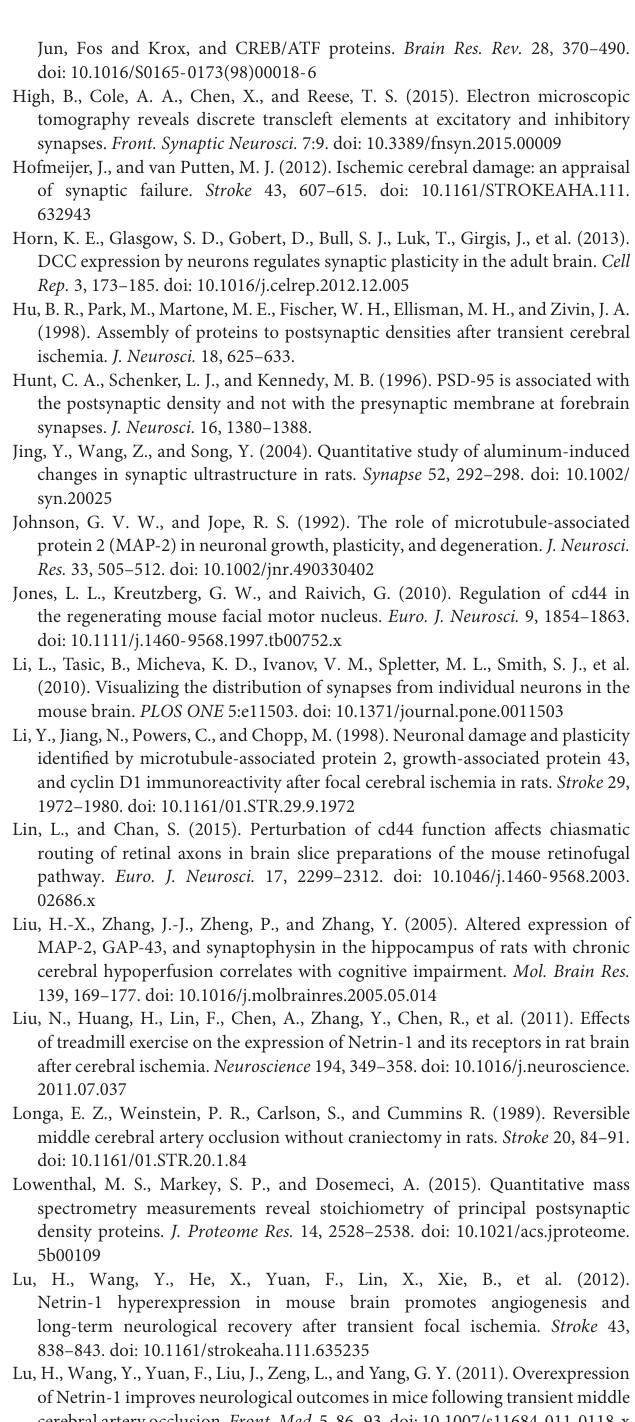
FIGURE S3 | Western-blot analysis of the supplementary groups. (A) The representative images of western-blot analysis for NF-200, GAP-43 and MAP-2. Rats in each group were sacrificed at Day 14 after the MCAO. (B) Western-blot analysis of NF-200 ( n = 3). (C) Western-blot analysis of GAP-43 ( n = 3), ∗ p < 0.01, as compared with the AAV-empty group, ∗ p < 0.05, as compared with the AAV-empty + DMSO group. (D) Western-blot analysis of MAP-2 ( n =